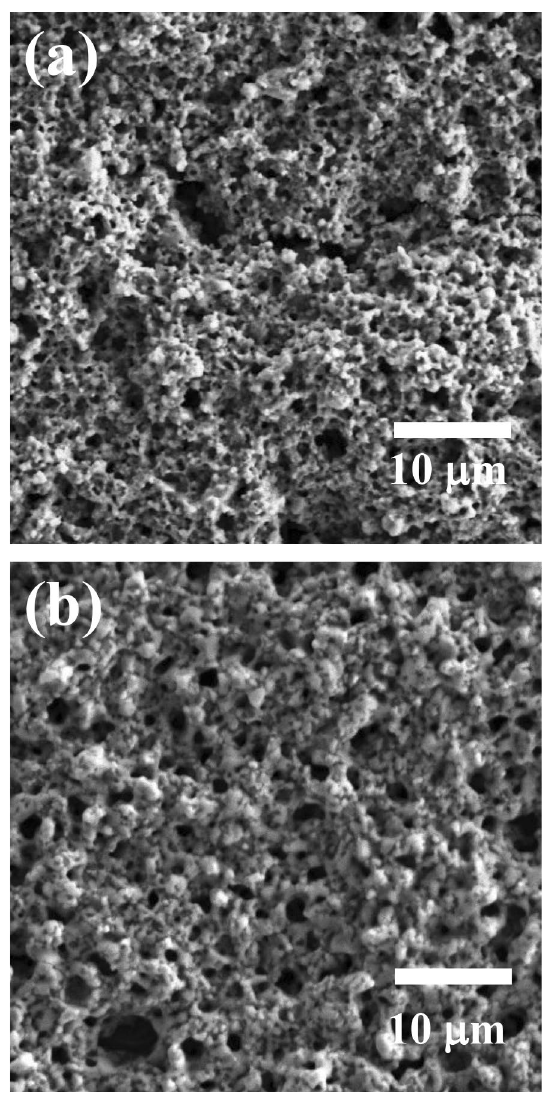
Figure 3. SEM images of surface of substrate coated with silver phosphate via calcination at ( a ) 300 °C and ( b ) 500